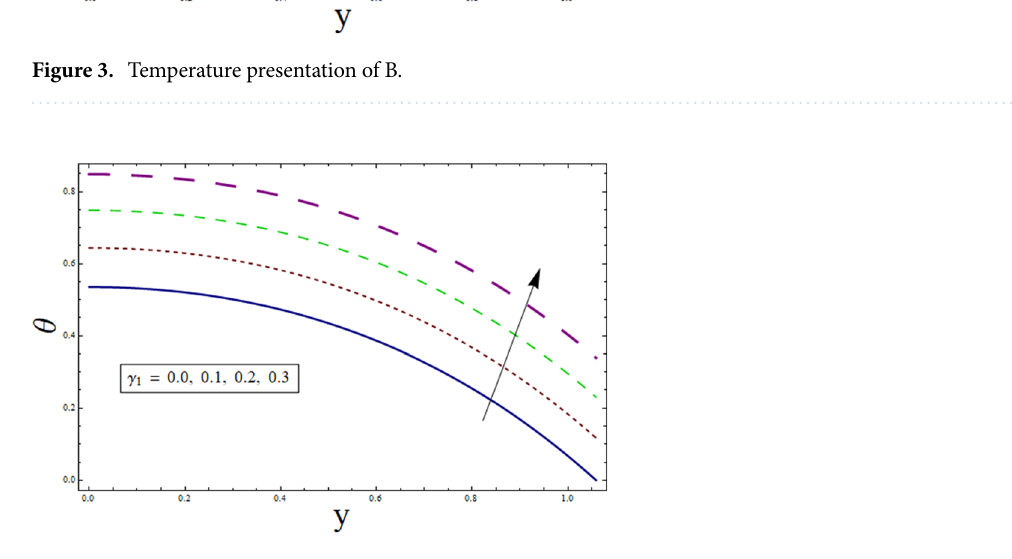
Figure 4. Temperature presentation of γ 1